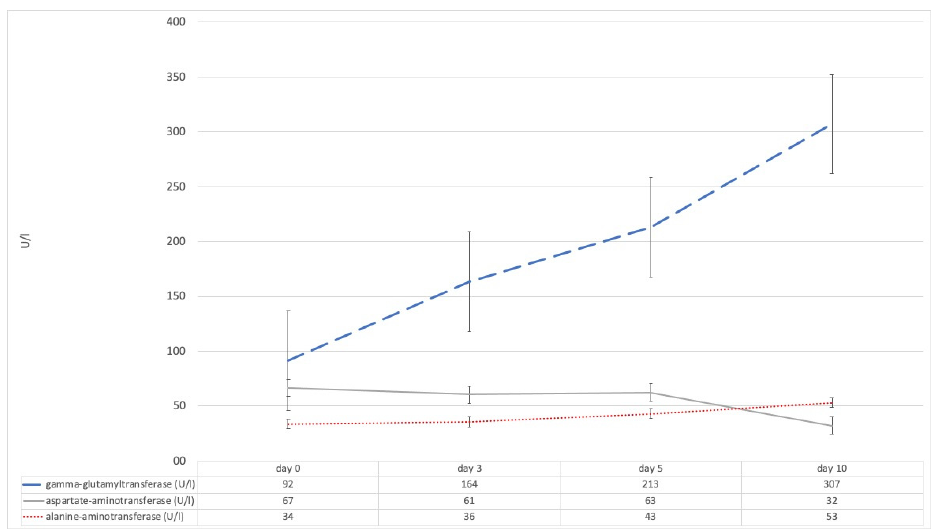
Figure 1. Trends of evaluated biomarkers of hepatitis and cholestasis from the day of diagnosis to day 10 of the course of acute respiratory distress syndrome; statistical significance was only determined for gamma-glutamyltransferase after Bonferroni correction ( p < 0.001).